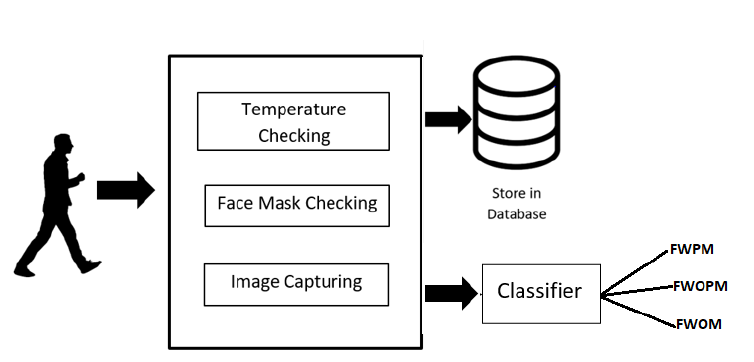
Figure 7. Temperature measuring and mask detection